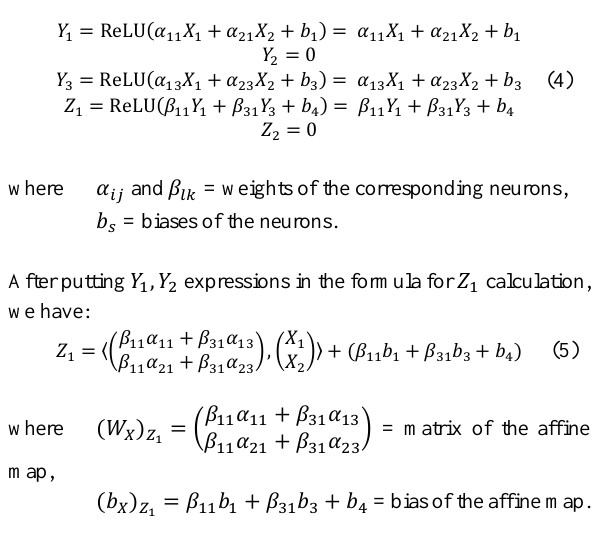
Figure 2. vector X = (X 1 , X 2 ) is passed as an input to the CNN. We marked in red connections, that are active for a current input. One can see that connections with Y 2 are inactive, because Y 2 = 0 ( ReLU(⋅) = 0 ) and does not affect the final